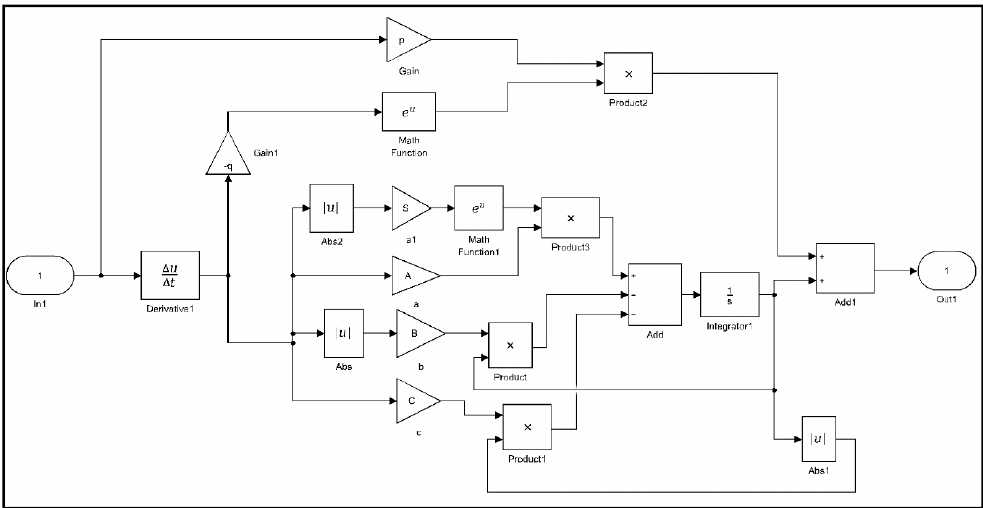
Figure 6. Generalized Bouc–Wen (GB–W) model implemented with MATLAB/Simulink.